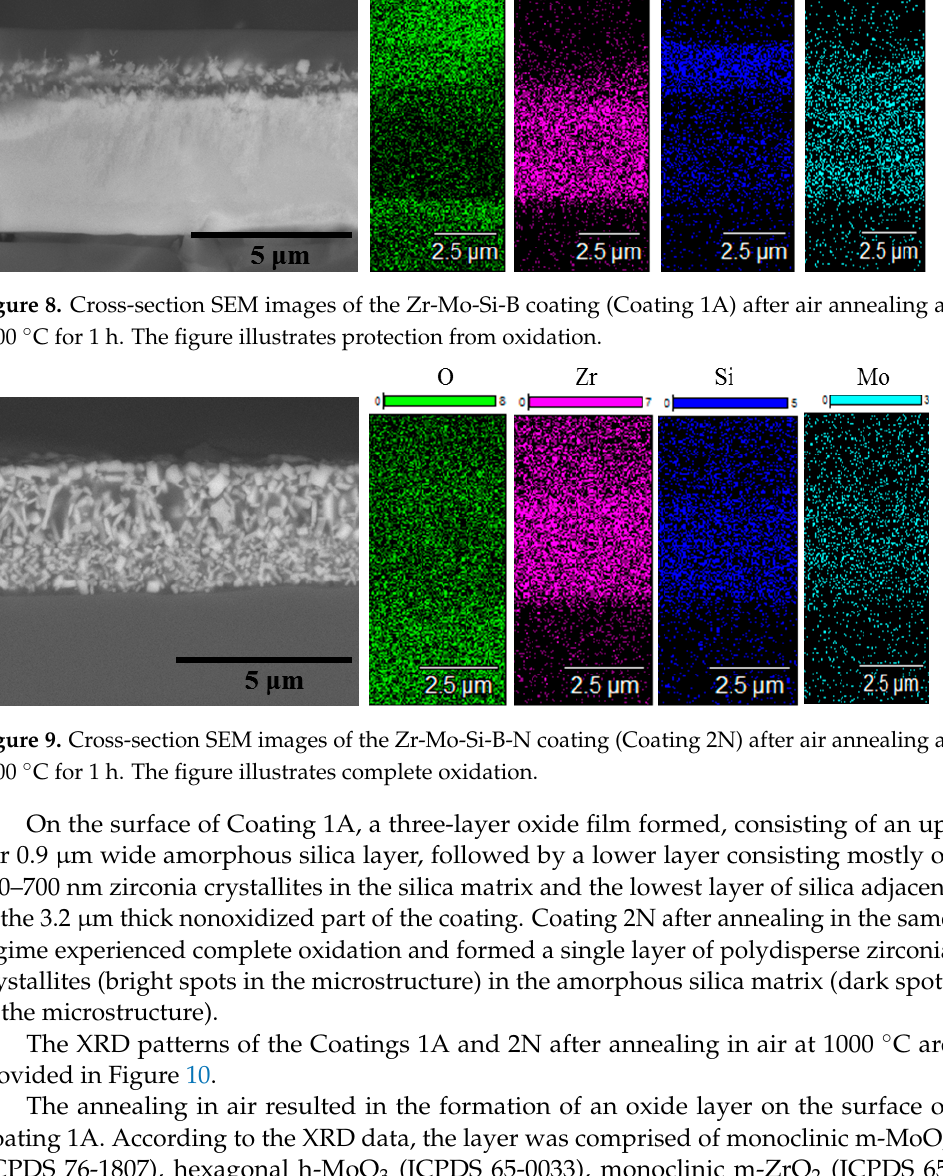
Figure 4. XRD patterns of Coatings 1A ( a ) and 2N ( b